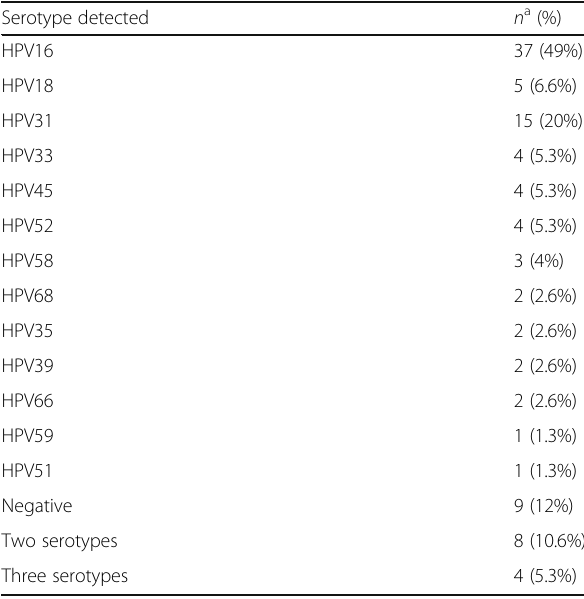
Table 1 Frequency of hrHPV types in 75 cases of HSIL/AIS/ Invasive carcinoma Serotype